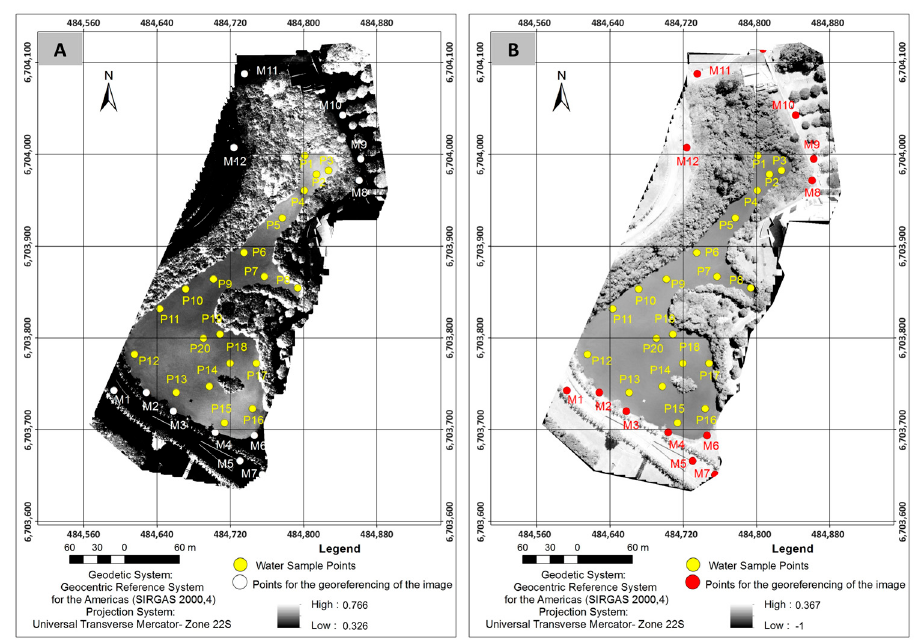
Figure 7. Images generated by the compositions of the spectral band b 9 instead of the band b 5 obtained by ANN: ( A ) NDVI image; and ( B ) NDWI image.